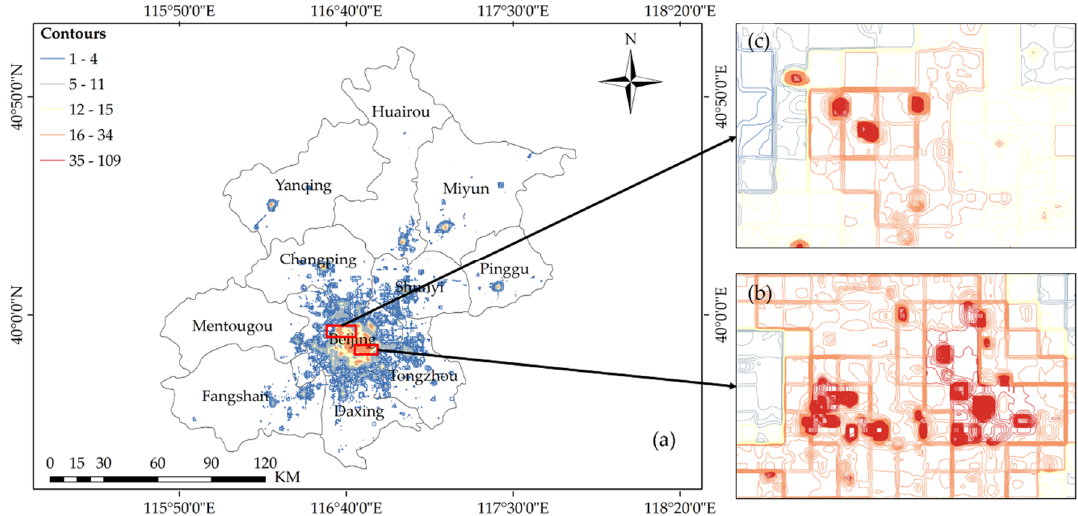
Figure 6. ( a ) Contour map of Beijing. ( b ) Zhongguancun region and ( c ) Jianguomen region are enlarged to show the details.